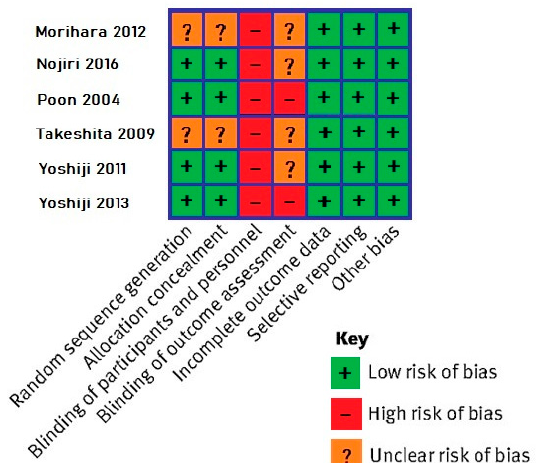
Figure 2. Results of the Cochrane tool for bias assessment in randomized controlled trials [29,32,33,35,37,38].